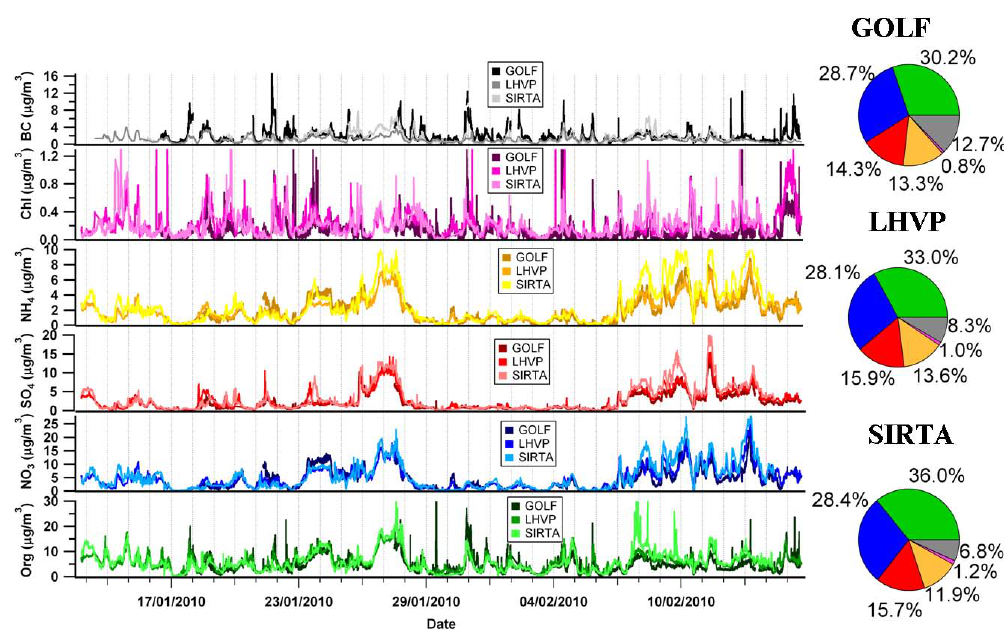
) , nitrates (NO − ) , ammonium (NH + ) , chlorine 4 3 4